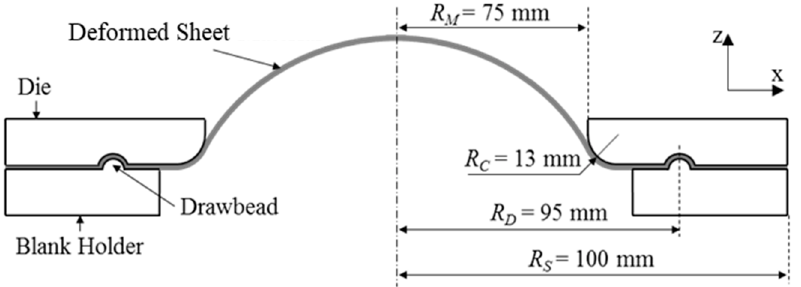
Figure 2. Representation of the bulge test, identifying the main dimensions of the tools in agreement with Santos et al. Data from [17].